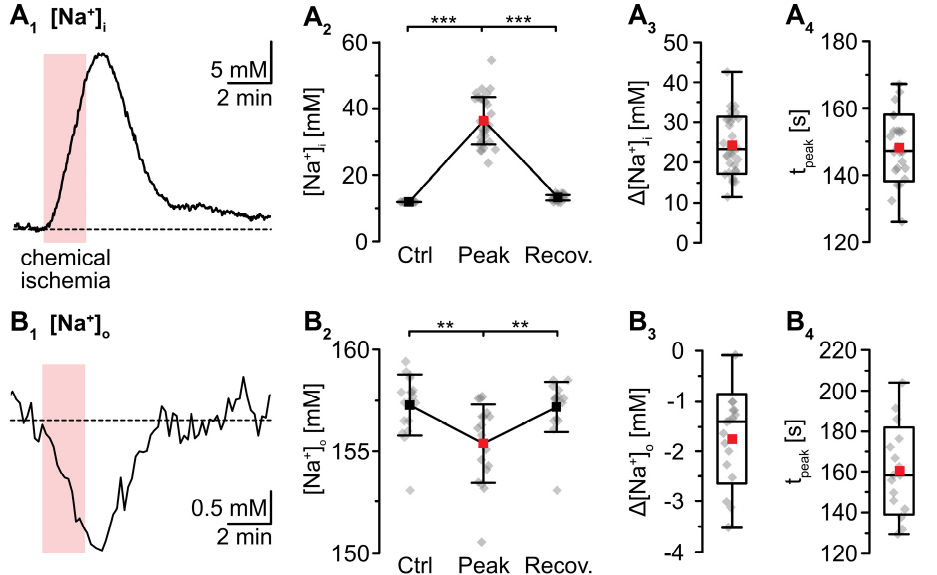
Figure 2. Changes in Na + induced by a chemical ischemia for 2 min. ( A ) Astrocytic [Na + ] i . ( A 1 ): [Na + ] i increase in an individual astrocyte. ( A 2 ): Plot illustrating baseline [Na + ] i (data taken from [41]), peak changes in [Na + ] i , and subsequent recovery of [Na + ] i . Shown are individual data points (grey diamonds), means (squares), and SDs (whiskers). ( A 3 , A 4 ): Box plots illustrating peak changes in [Na + ] i ( A 3 ) as well as the time-to-peak ( A 4 ). ( B ) Same illustration as in ( A ) for changes in [Na + ] o . ( B 1 ): Individual measurement. ( B 2 ): Plot illustrating baseline [Na + ] o , peak changes in [Na + ] o , and its subsequent recovery. ( B 3 , B 4 ): Box plots of peak changes in [Na + ] o ( B 3 ) and the time-to-peak ( B 4 ). Box plots in ( A 3 , A 4 ) and ( B 3 , B 4 ) show individual data points (grey diamonds), means (squares), medians (horizontal lines), SD (boxes), and min/max (whiskers). ( A 2 , B 2 ): ** p < 0.005, *** p < 0.0005 (Šid á k corrected significance